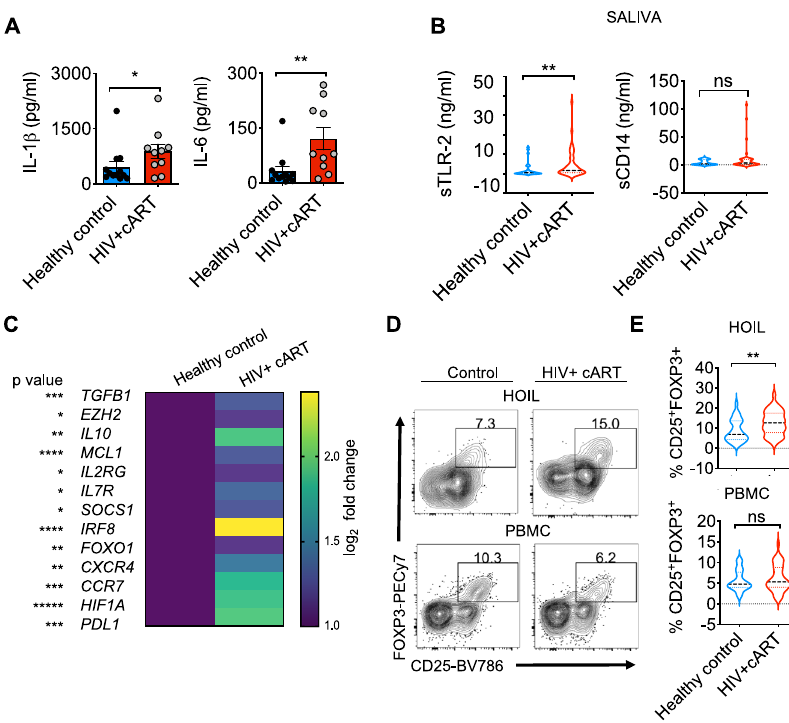
Fig. 2 In fl ammatory cytokines, s-TLR2, and CD4 + CD25 + FOXP3 + cells are enriched in gingival mucosa of HIV + patients on therapy. A Cells from gingival mucosa were re-stimulated with PMA/Ionomycin for 4 h and supernatants were collected for ELISA analyses of IL-1 β (left) and IL-6 (right) (Control, n = 13; HIV + cART, n = 10; * P = 0.02; one-tailed; Mann – Whitney test). B ELISA quanti fi cation of s-TLR2 (left) and s-CD14 (right) levels in saliva (Control, n = 32; HIV + cART, n = 46; ** P = 0.007; two-tailed; Mann – Whitney test). C Transcriptome pro fi ling was performed as in Fig. 1. Heatmaps of genes encoding literature-curated T reg signature proteins differentially regulated in gingival mucosa. Flow cytometric analyses of CD45 + CD3 + CD4 + gated HOIL cells for CD25 + FOXP3 + cell proportions, showing representative contour plots ( D ), and statistical analysis of T reg proportions ( E ) in HOILs (above) and PBMCs (below) (Control, n = 31; HIV + cART, n = 44). Mean value ± SEM are plotted. (** P = 0.0094; two-tailed; Mann – Whitney test). Source data are provided as a Source data fi